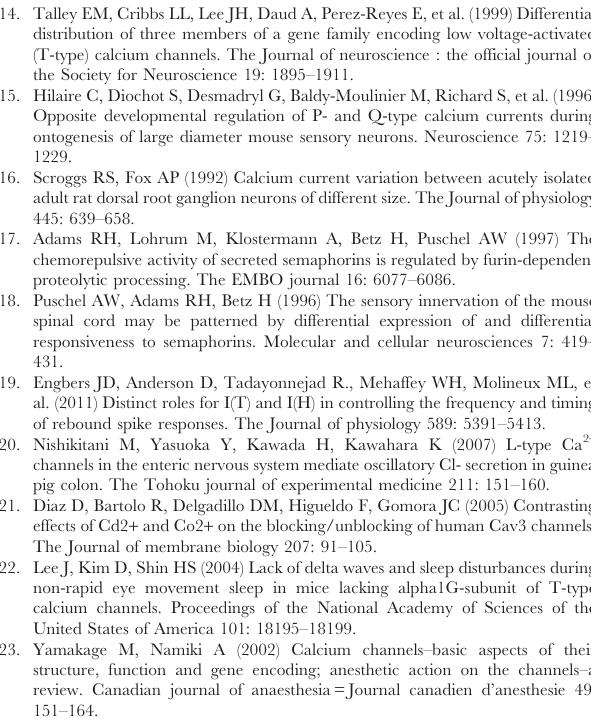
Figure 8. Influence of SNX482 (50 nM), a specific blocker of R type LVA VGCC on growth cone collapse rate and changes in Sema3A (100 ng/mL) induced intracellular calcium concentration. A) Growth cone collapse rate in control group (black bar) Sema3A treated group (red bar), SNX482 treated group (blue bar) or both treatments (green bar). B) Changes of relative Fura-2 340/380 fluorescence in control conditions (black curve) and 50 nM of SNX482 (blue curve) followed by DRG neuron treatment with Sema3A (red and green curves respectively) at indicated time point. All data have been normalized to the point, before Sema3A was added (this point equals to 1 arbitrary unit AU). C) Bars represent mean 6 SEM of relative Fura2 fluorescence: black bar represent control Fura-2 fluorescence; red bar represent mean fluorescence in presence of Sema3A; blue bar indicates condition in presence of SNX482 and green bar indicates conditions where Sema3A was added in presence of SNX482; ***p , 0.001; ns – not significant. In the panels A and C upper, middle and lower lines represent statistical difference of the corresponding groups from control, from Sema3A, and SNX482 groups respectively.